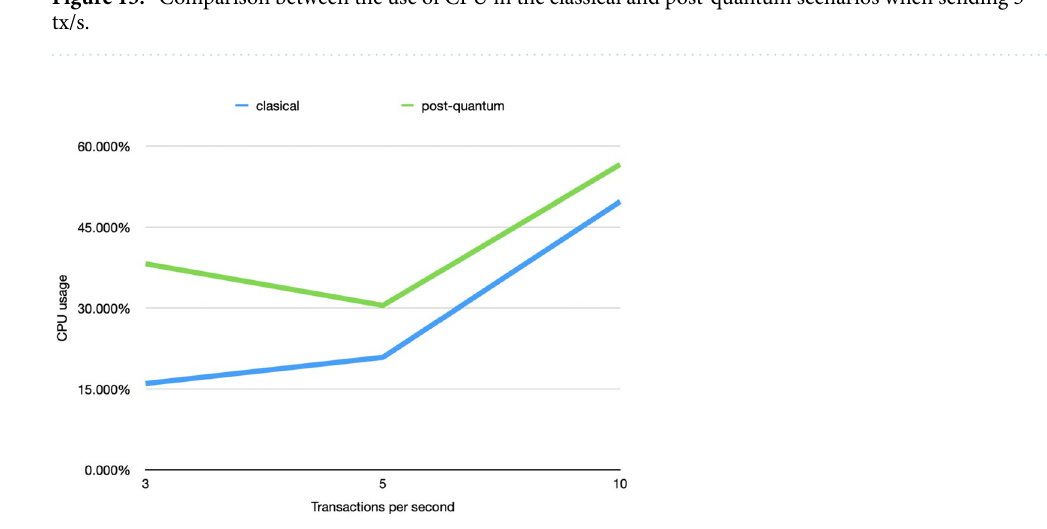
Figure 16. Comparison between the average use of CPU in the classical and post-quantum scenarios when sending 3, 5, and 10